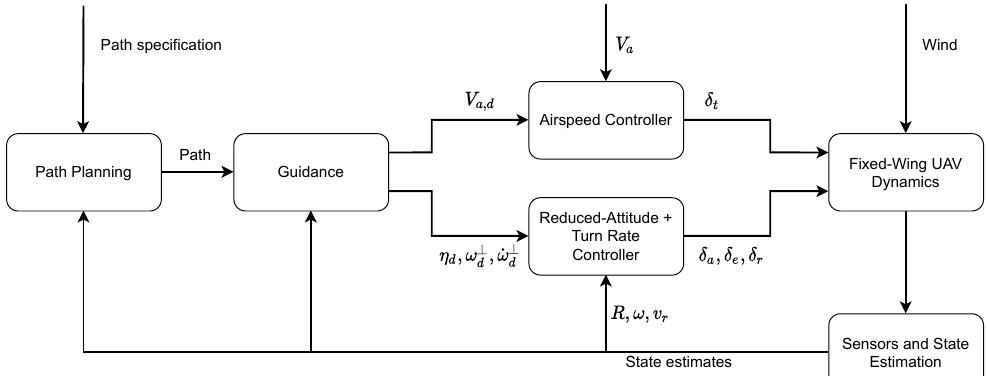
Figure 4. Block diagram of a guidance, navigation and control (GNC) architecture for a fixed-wing